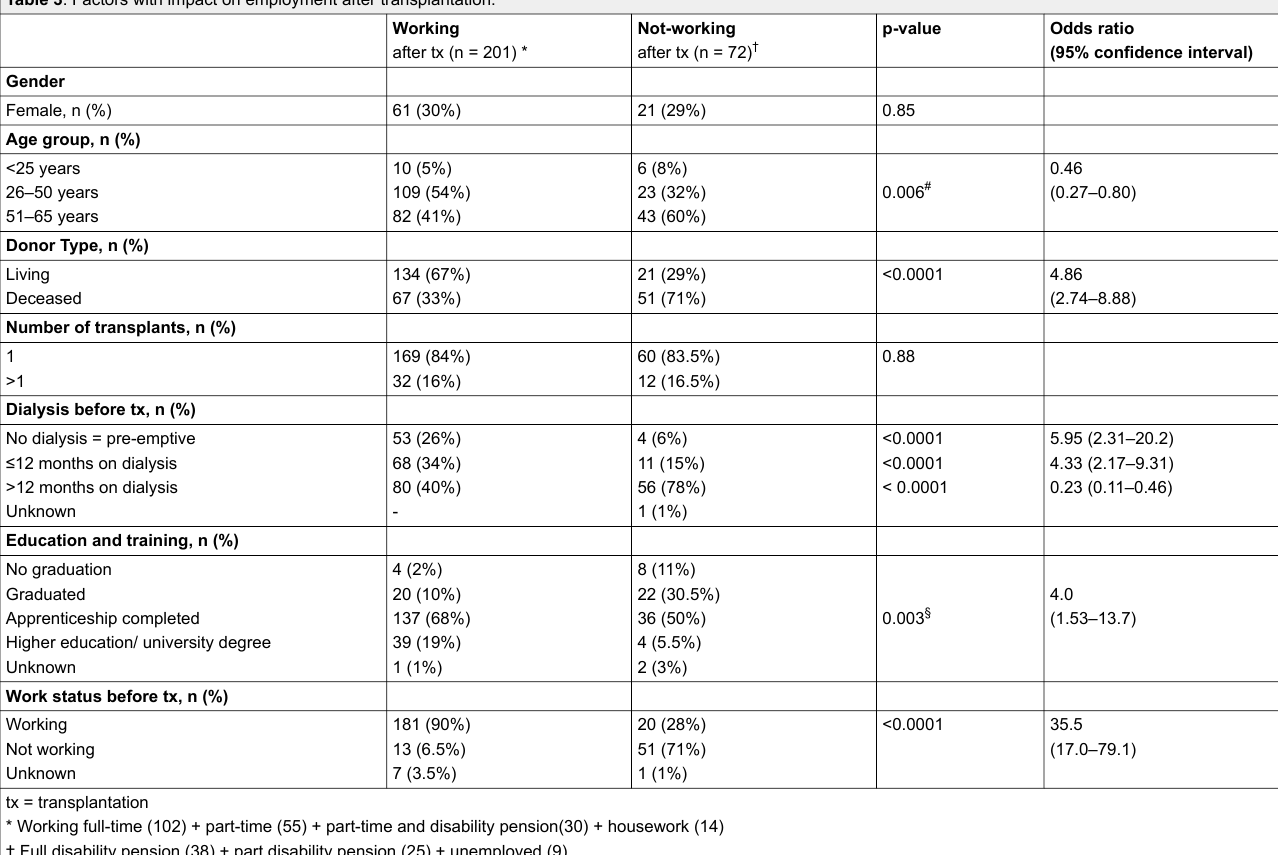
Table 3 : Factors with impact on employment after